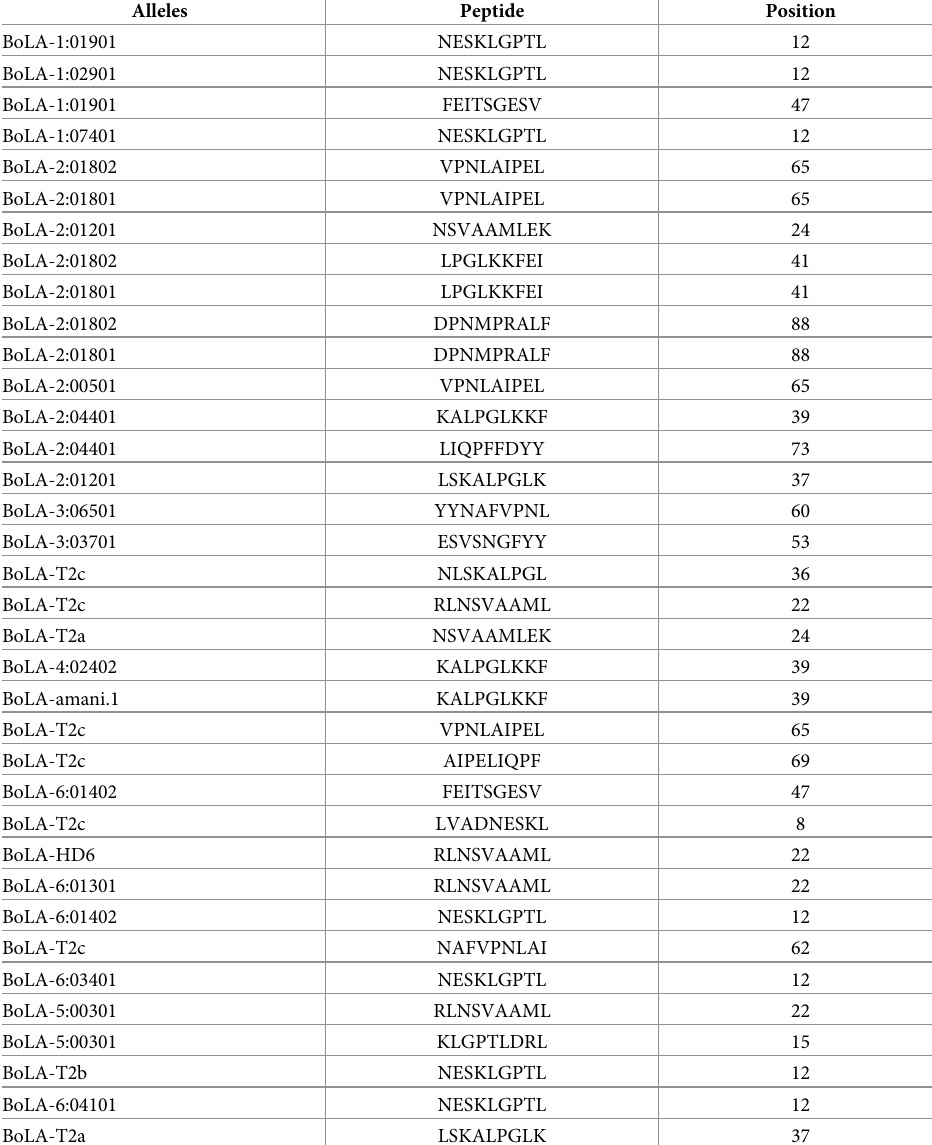
Table 2. ht-MAP-2191 CTL epitopes with highest score. Alleles Peptide Position BoLA-1:01901